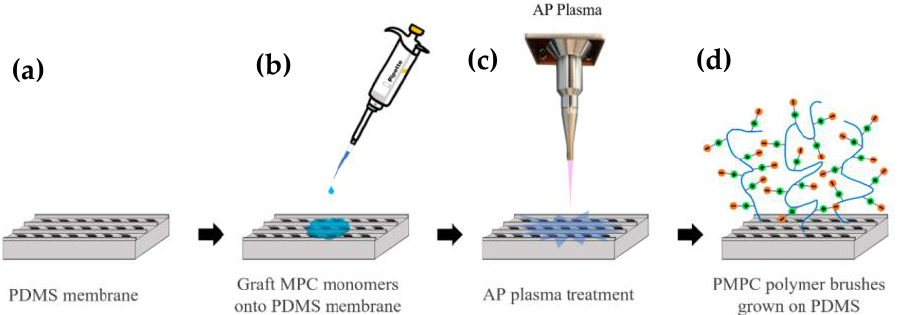
Figure 3. Schematic diagram of the replica of the PDMS-based bionic Nepenthes peristome-like structure with 2-methacryloyloxyethl phosphorylcholine (MPC) immobilization by atmospheric plasma. ( a ) The replica PDMS membrane was pre-treated by plasma cleaning for 1 min; ( b ) PDMS immersed in MPC solution; ( c ) MPC monomers were polymerized by oxygen atmospheric plasma and formed ( d ) MPC polymer brushes.